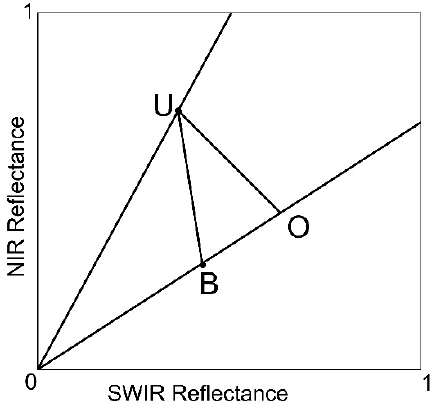
Figure 3. Example of the pre/postfire trajectory of a pixel in the short-wave infrared reflectance–near infrared reflectance (SWIR–NIR) space. A pixel moves from nonburnt (U) to burnt (B). O resembles the position of an optically sensitive burnt pixel. The dNBR is sensitive to offsets | UO | and insensitive to offsets | OB | [16].